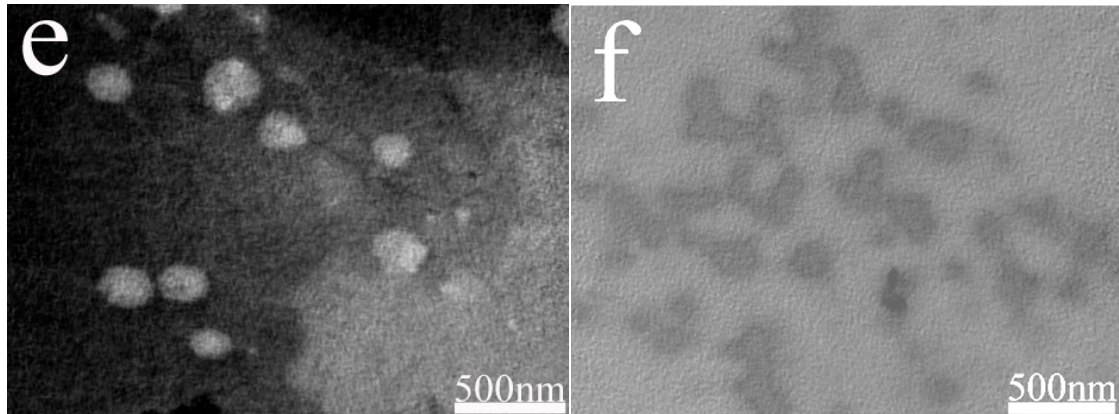
Figure 4. a , c , and e are the AES, APG, and SDS emulsions’ TEM images after one hour. b , d , and f are the AES, APG, and SDS emulsions’ TEM images after 3 weeks.